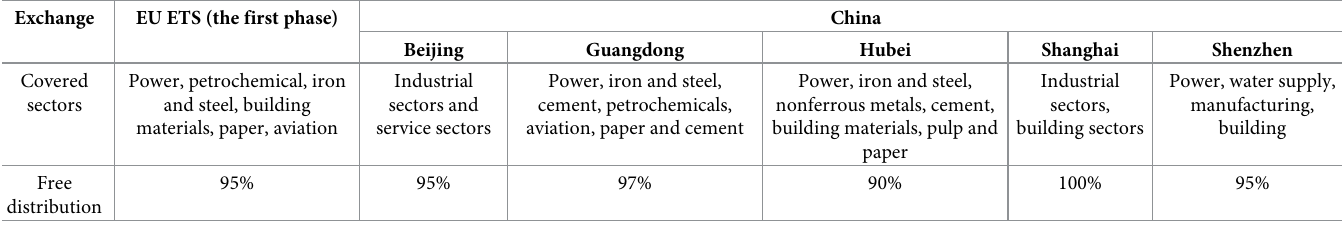
Table 7. Covered sectors in the EU ETS and China’s carbon trading